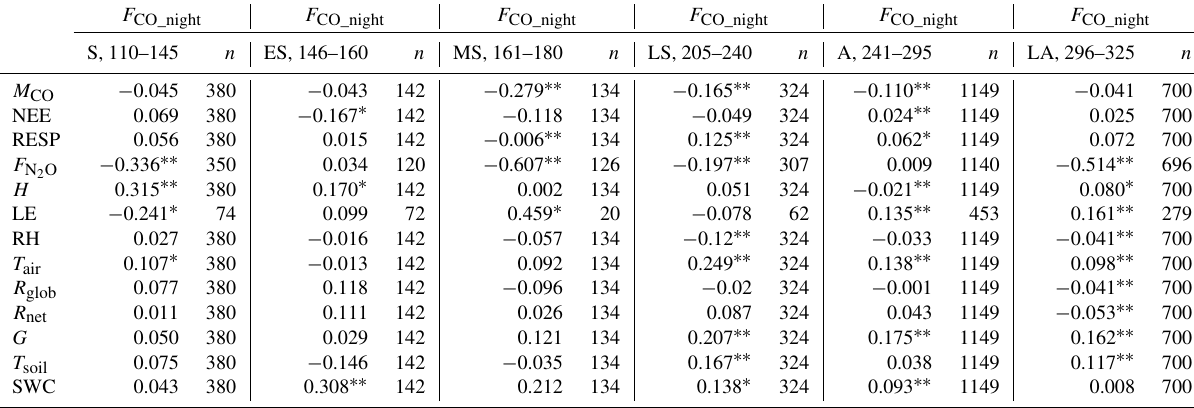
Table 4. Pearson correlation matrix for half-hour night-time CO fluxes ( F CO_night ) during six periods (S is spring, ES is early summer, MS is midsummer, LS is late summer, A is autumn, LA is late autumn) at the reed canary grass crop in Maaninka. M CO is CO mixing ratio, NEE is net ecosystem exchange, RESP is ecosystem respiration, F N is N 2 O flux, H is sensible heat flux, LE is latent heat flux, T air is air 2 O temperature, R glob is global radiation, R net is net radiation, G is soil heat flux, T soil is soil temperature at 2.5cm, SWC is soil water content at 2.5cm.